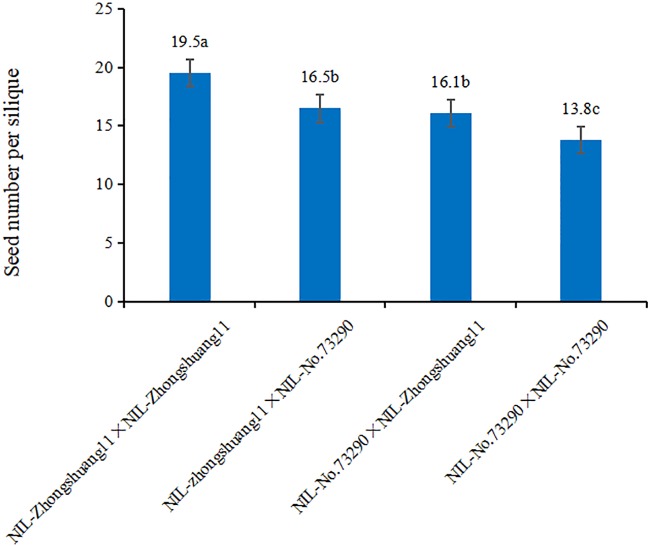
Comparison of the seed number per silique between the self- and cross-pollinations. The vertical and horizontal axes represent the seed number per silique of the different combinations between NIL-Zhongshuang11 and NIL-No. 73290, respectively. The letter following the numerals represent the significance of difference in multiple comparisons.